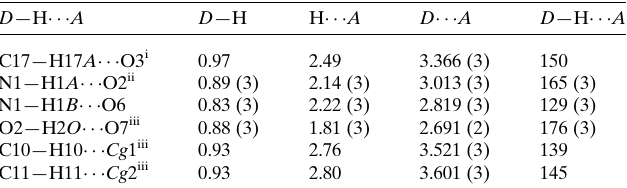
Table 2 Hydrogen-bond geometry (A˚ , (cid:2) ) for BF2. Cg 1 and Cg 2 are the centroids of the O1/C1/C2/C3/C8 and C3–C8 rings, respectively.